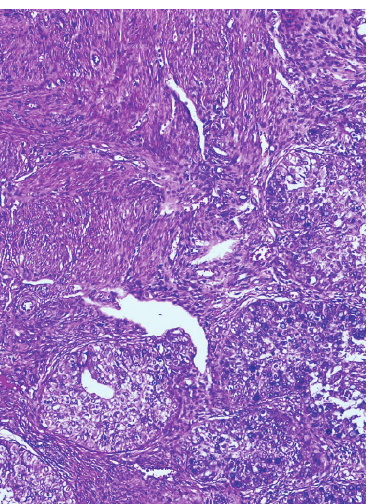
Figure 2: Tumour cells in signet-ring cell morphology; H&E ×